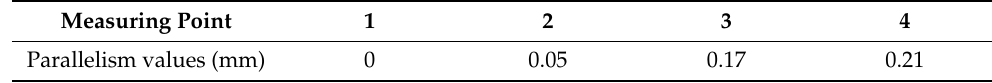
Table 6. Parallelism values of each measuring point. Measuring